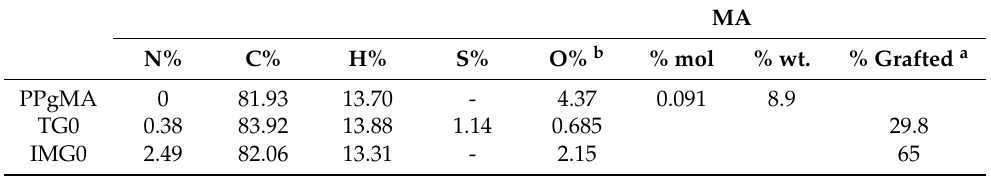
Table 2. Elemental analysis on maleated PP and the grafted products. N% C% H% S% O% b % wt.